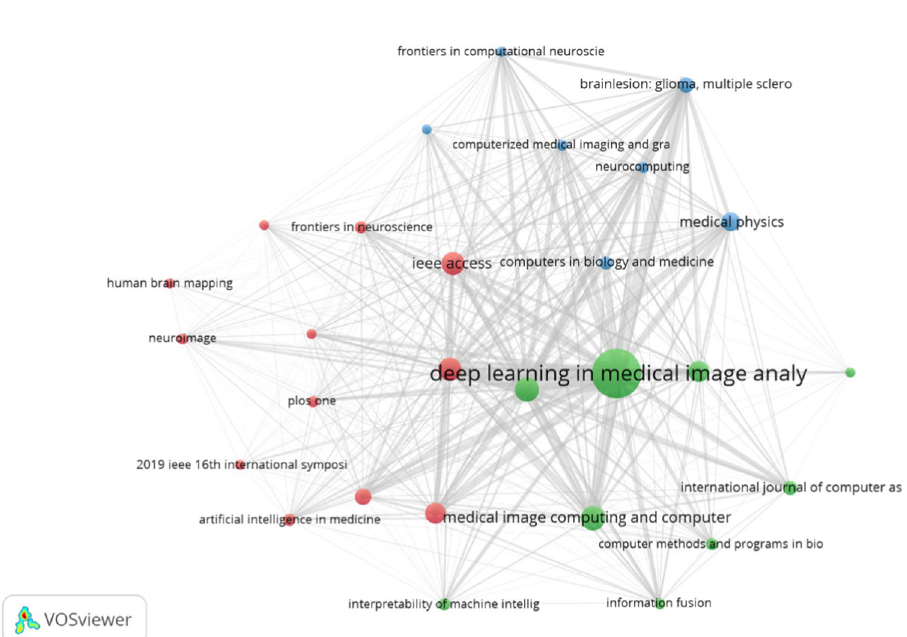
Fig. 11 Journal bibliographic coupling network of MMDLM- related